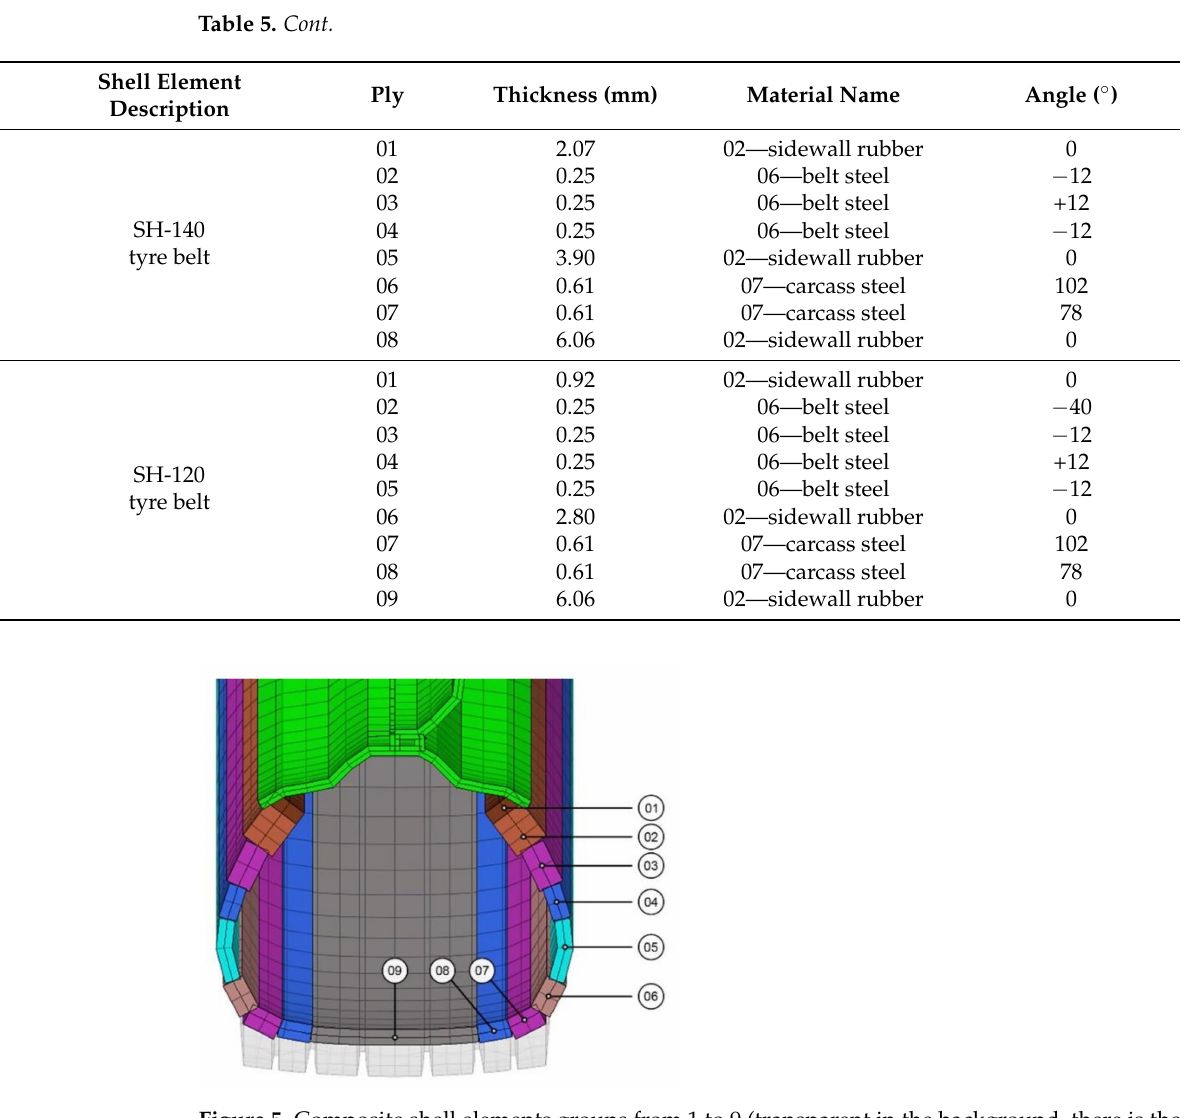
Figure 5. Composite shell elements groups from 1 to 9 (transparent in the background, there is the complex tyre model).